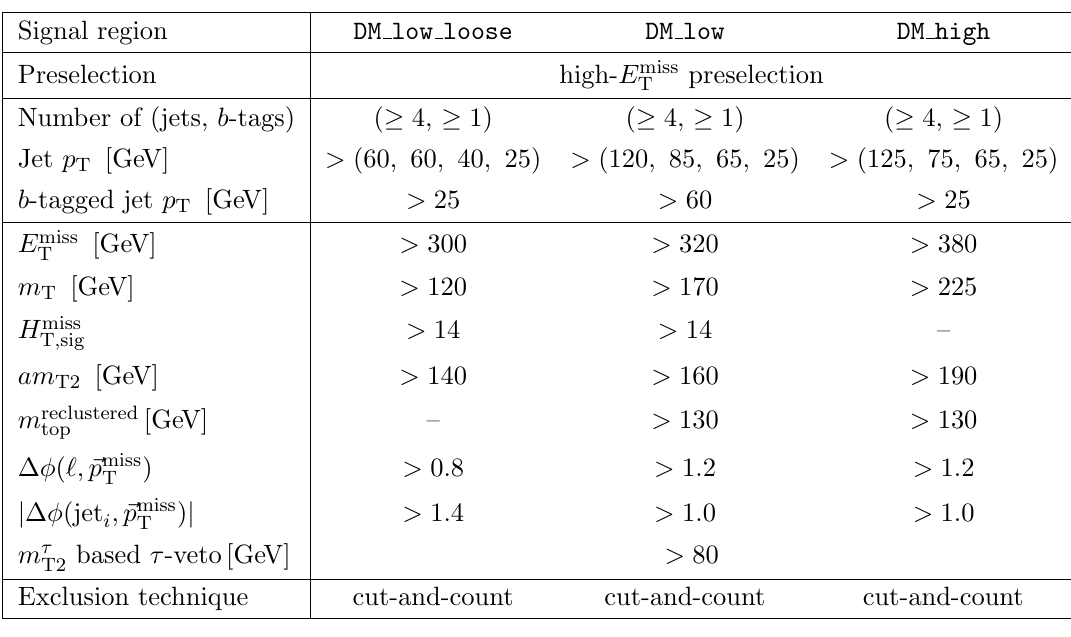
Table 11 . Overview of the event selections for the DM low loose , DM low , and DM high SRs. List values are provided in between